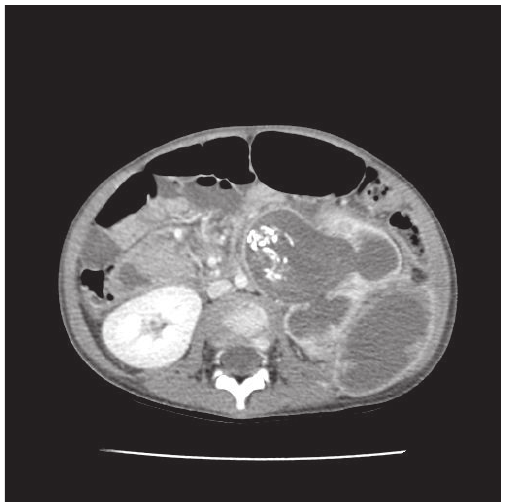
Figure 1: Predrainage CT with contrast demonstrates calcified debris filling the pelvis and proximal ureter. There is destruction of the lower pole renal parenchyma (not pictured) which is contiguous with a 7 × 6 × 5 cm abscess and destruction of the upper pole renal parenchyma with a 4 × 3 × 2 cm abscess.